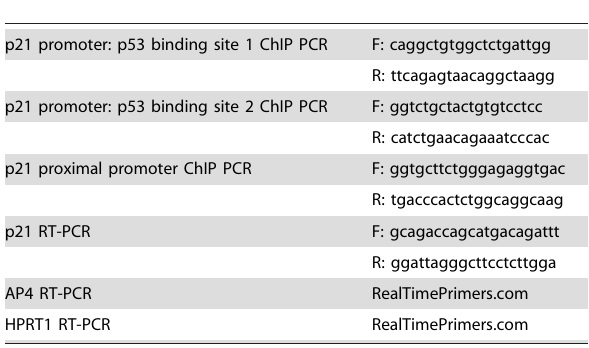
Table 1. List of